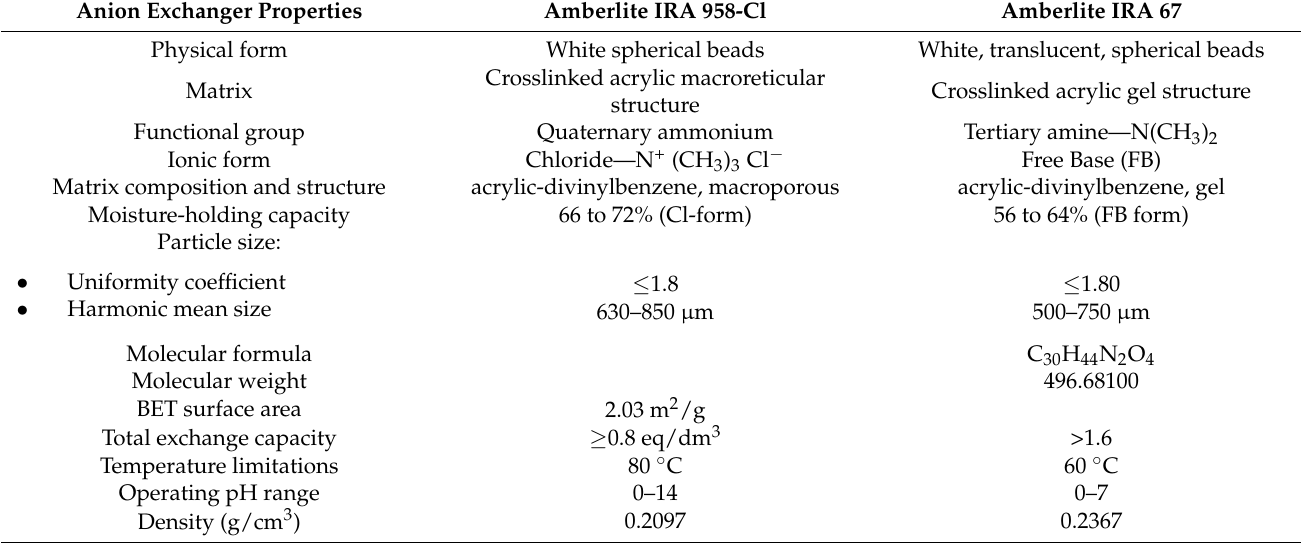
Table 1. Properties of Amberlite IRA 958-Cl [43,56] and Amberlite IRA67 [43,58].